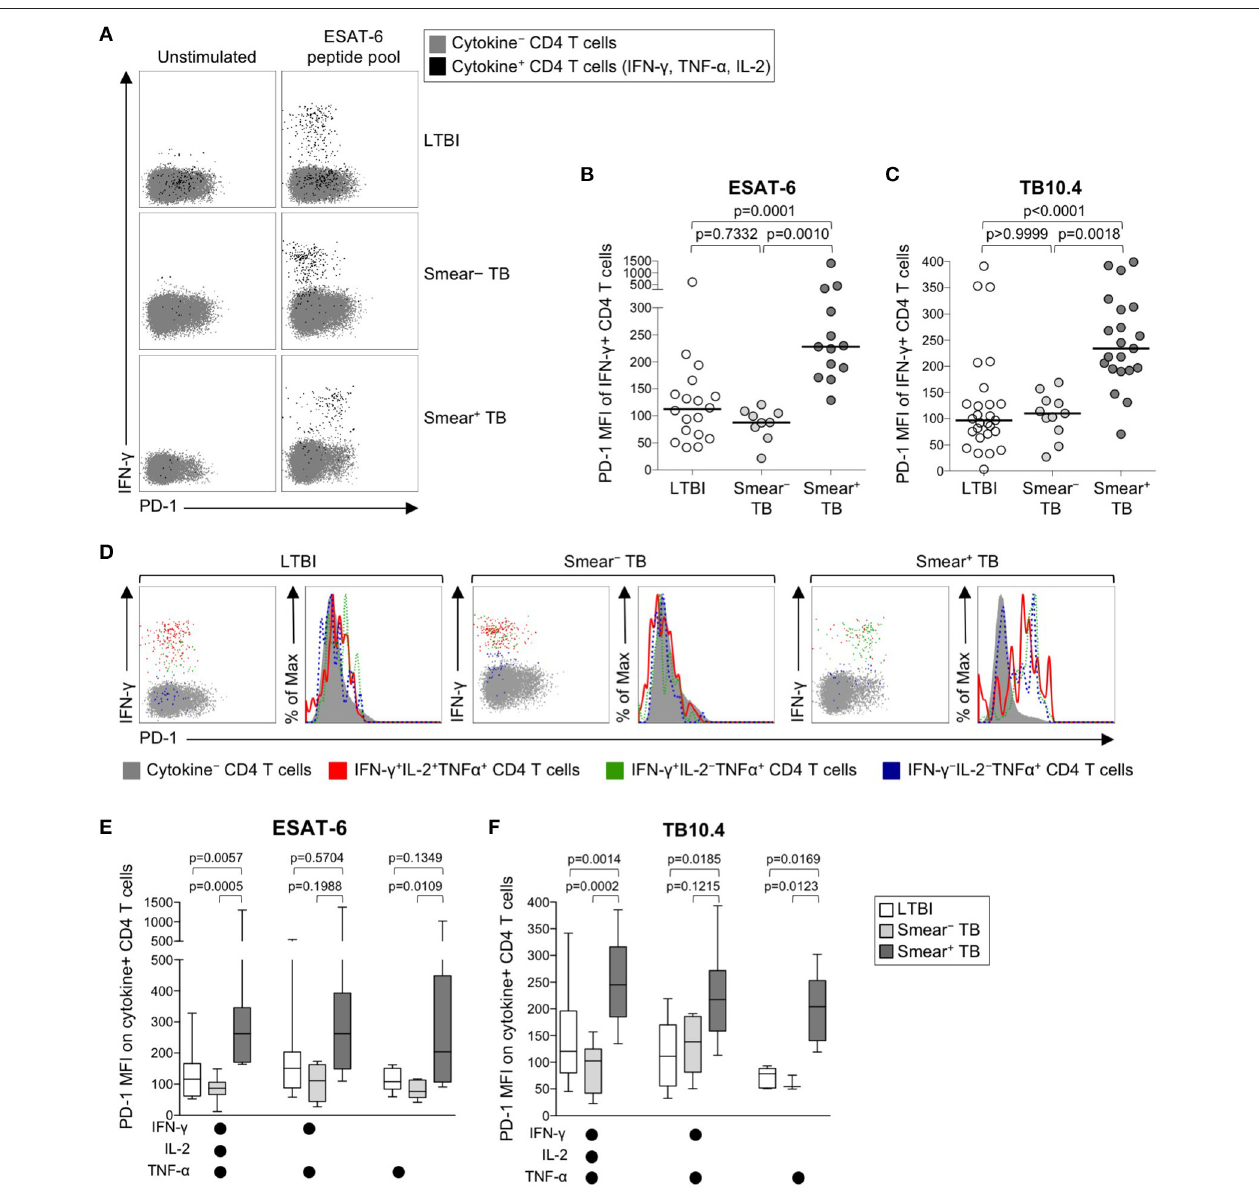
FIGURE 2 | PD-1 expression on Mtb-specific CD4T cells is increased in patients with smear + TB, compared with smear − TB patients and individuals with LTBI. Whole blood from individuals with LTBI ( n = 33), and patients with smear − TB ( n = 12) and smear + TB ( n = 29), was stimulated for 8h with an ESAT-6 peptide pool and a TB10.4 peptide pool; PD-1 expression was measured on total CD4T cells and Ag-specific CD4T cells producing IFN- γ , TNF- α , and/or IL-2. (A) Representative flow cytometry data indicating PD-1 expression by ESAT-6-specific CD4T cells producing IFN- γ , TNF- α , and/or IL-2. Flow plots are shown gated on viable CD3 + CD4 + lymphocytes; gray cells indicate cytokine − total CD4T cells and black cells indicate cytokine + (expressing any combination of IFN- γ , TNF- α , and IL-2) CD4T cells. (B) Composite data of PD-1 expression by IFN- γ + CD4T cells in individuals with a positive response to ESAT-6 (LTBI: n = 18; smear − TB: n = 9; smear + TB: n = 13). (C) Composite data of PD-1 expression by IFN- γ + CD4T cells in individuals with a positive response to TB10.4 (LTBI: n = 27; smear − TB: n = 11; smear + TB: n = 21). (D) Representative flow cytometry data indicating PD-1 expression by the indicated subsets of cytokine-producing CD4T cells following stimulation with ESAT-6. Dot plots and histograms are shown gated on viable CD3 + CD4 + cells. Gray cells indicate cytokine − (IFN- γ − IL-2 − TNF- α − ) CD4T cells; red indicates IFN- γ + IL-2 + TNF- α + cells; green indicates IFN- γ + IL-2 − TNF- α + cells; dark blue indicates IFN- γ − IL-2 − TNF- α + cells. Dot plots and histograms of PD-1 expression by ESAT-6-specific cytokine + CD4T cells are shown from the same donor with either LTBI, smear − TB, and smear + TB. (E,F) PD-1 expression on subsets of ESAT-6-specific (E) or TB10.4-specific (F) CD4T cells producing the indicated combinations of IFN- γ , TNF- α , and IL-2. Only cytokine + subsets present at ≥ 0.01% of CD4T cells, after subtraction of background cytokine production, were analyzed for PD-1 expression. Differences across three groups were assessed using a Kruskal-Wallis test; the p -values shown have been adjusted for multiple comparisons using Dunn’s post-test. Horizontal lines in (B,C) represent the median. For box plots in (E,F) , the horizontal line represents the median, the box the interquartile range, and the whiskers the 10th and 90th percentiles.